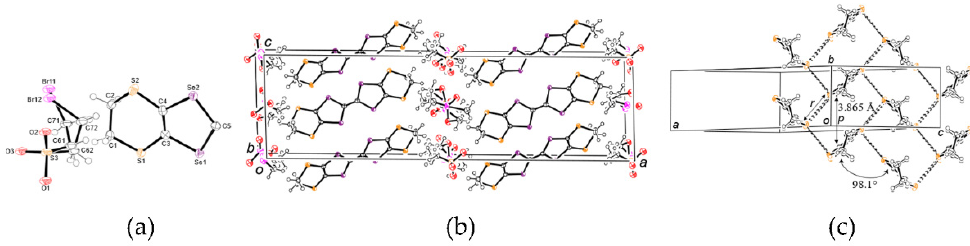
Figure 3. ( a ) Molecular structure of the asymmetric unit, ( b ) crystal structure, and ( c ) packing motif of the donor layer with one independent plane–plane distance and dihedral angle of 3 at 150 K.